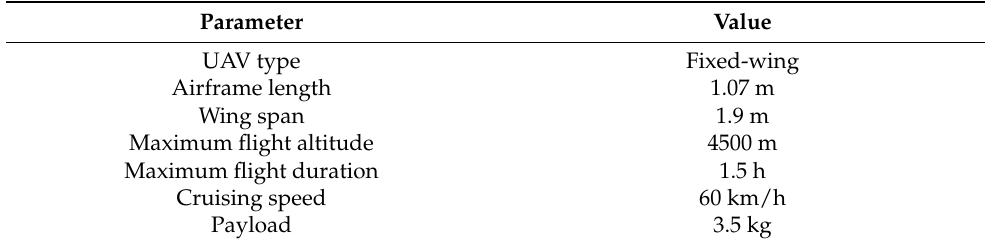
Table 1. The technical specifications of the UAV system.